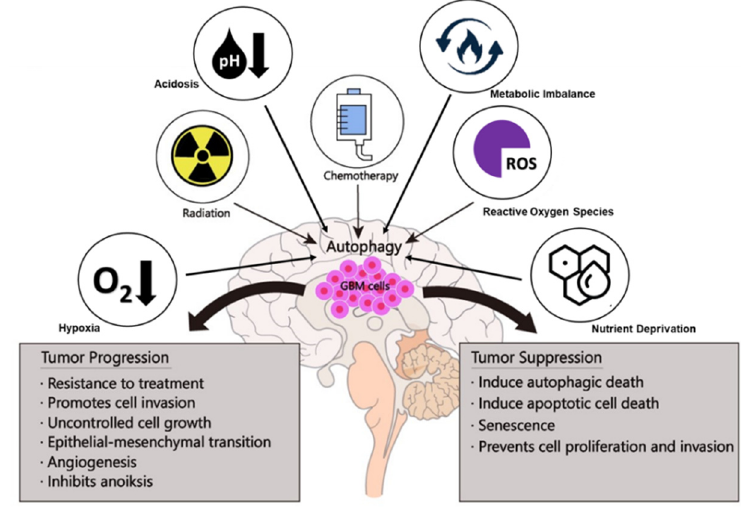
Figure 3. Dual functions of autophagy in GBM